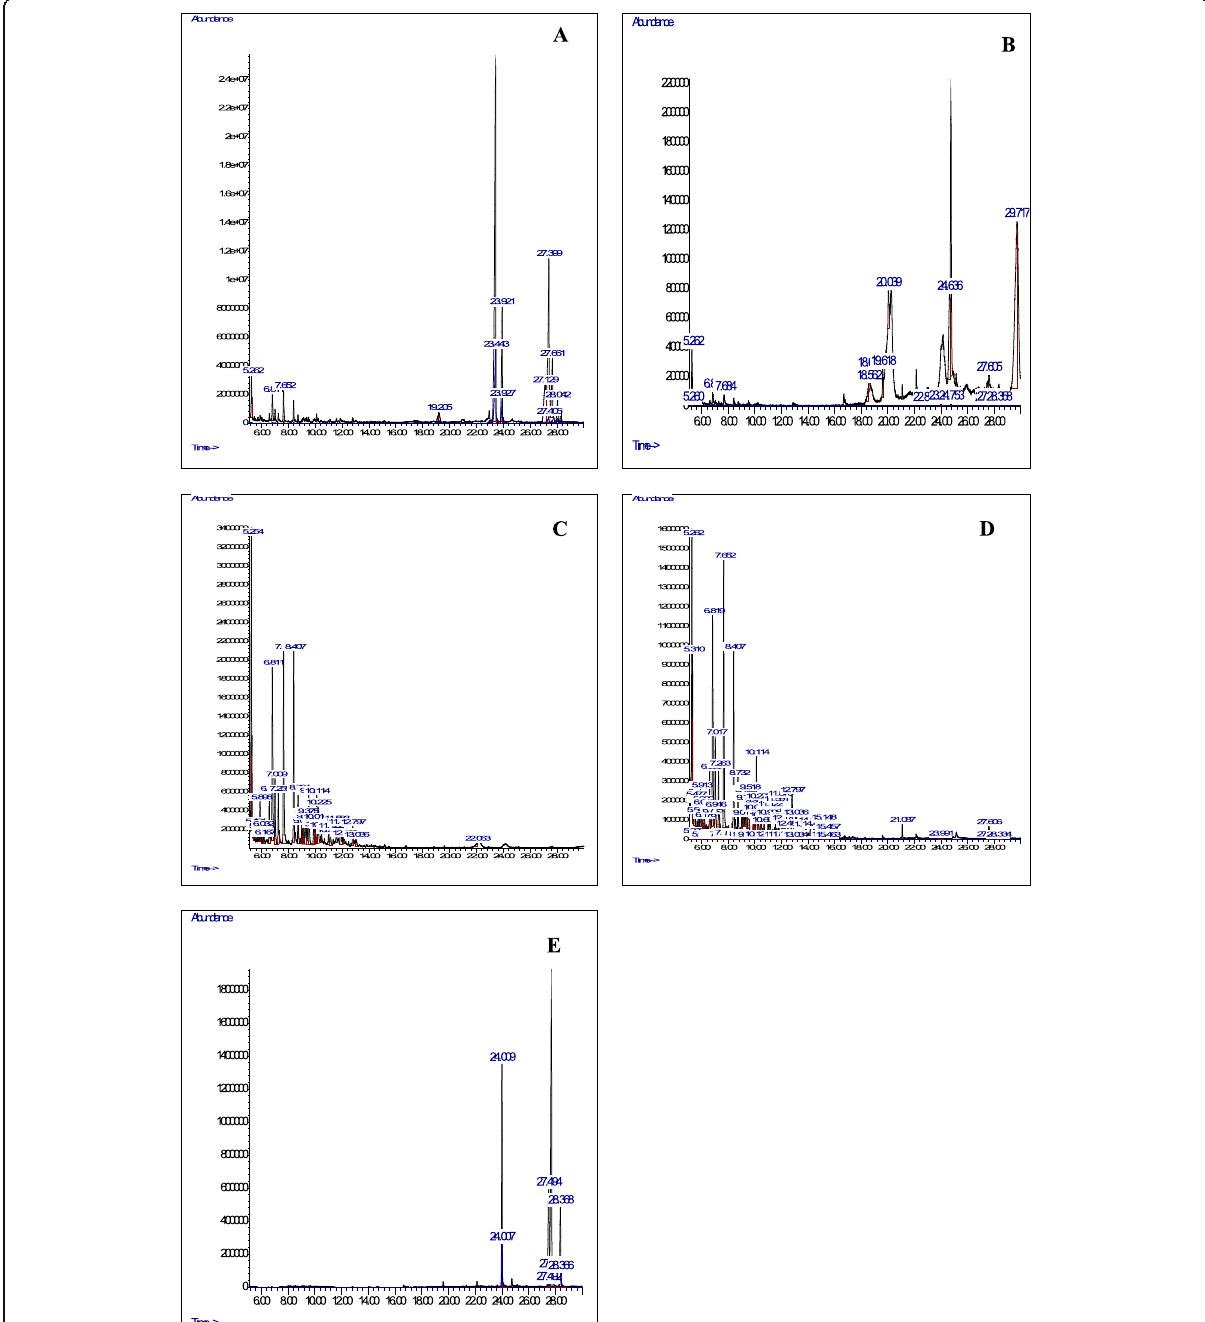
Fig. 4 GC-MS chromatograms: a Petroleum ether extract of A . occidentale . b Ethylacetate extract of A . occidentale . c n -hexane extract of P . guajava . d Petroleum ether extract of T . catappa . e Ethylacetate extract of T .